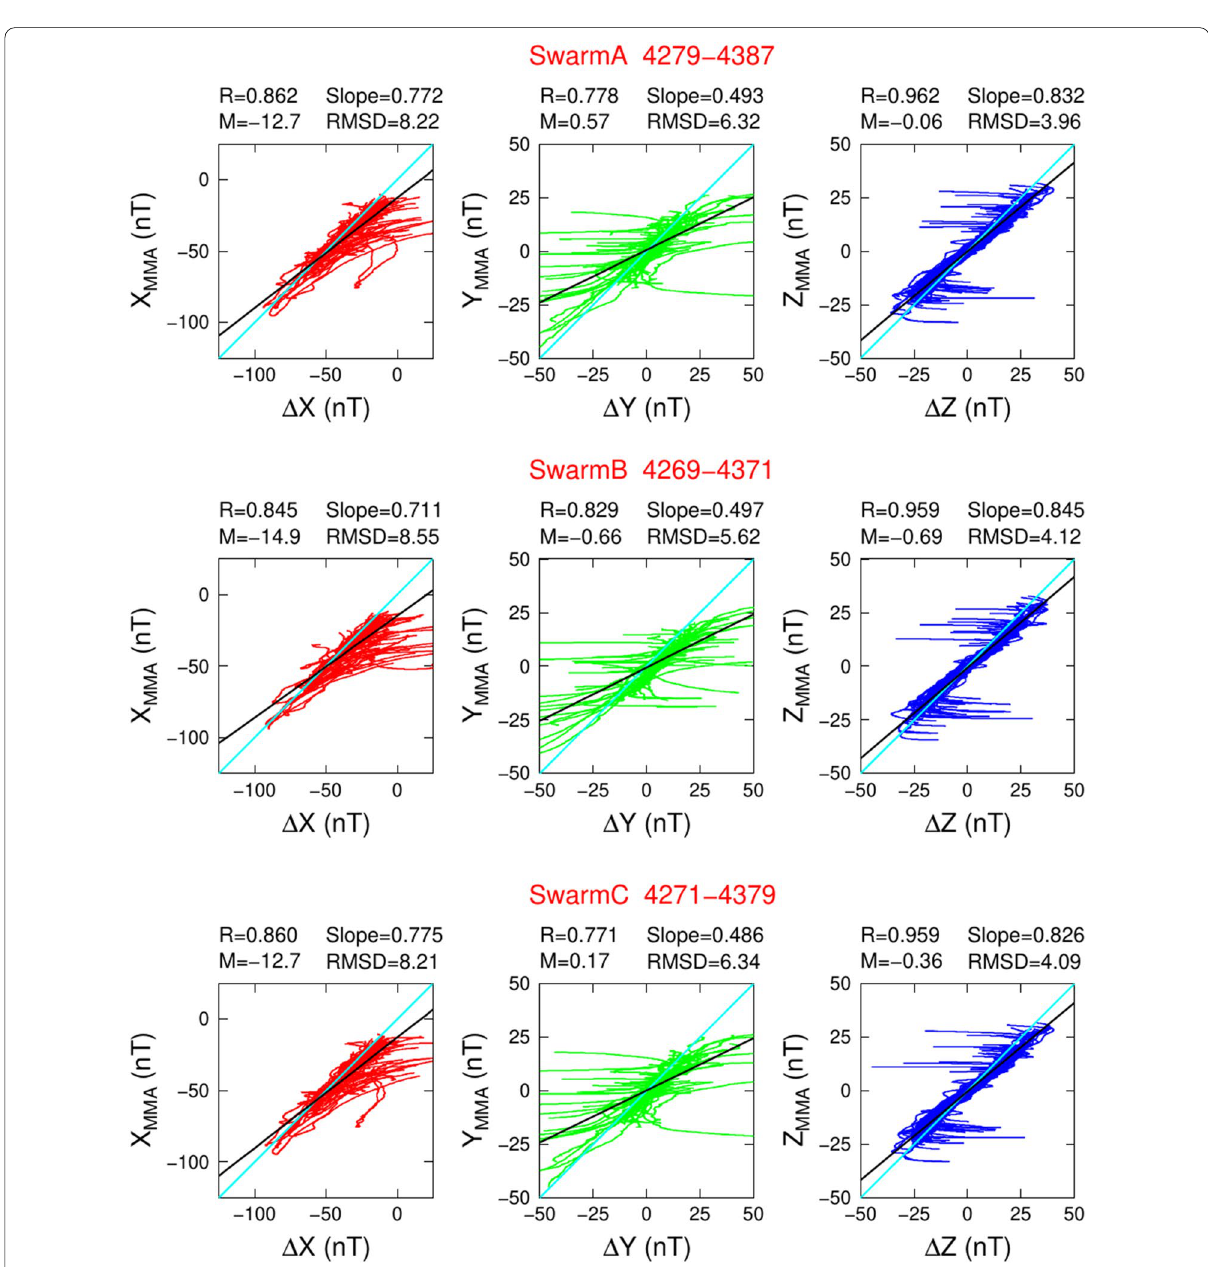
Fig. 1 The scatter plots and linear fits between the Swarm magnetic residuals (cid:31) X (red), (cid:31) Y (green) and (cid:31) Z (blue) and the components X MMA , Y MMA and Z MMA of the MMA model of the magnetospheric magnetic field (Sabaka et al. 2020) along Swarm A (top panels), Swarm B (middle panels) and Swarm C (bottom panels) satellite tracks. The results are shown for a moderate magnetic storm of 84,5-h duration from April 11 to April 15, 2014. The Dst index equals − 81 at the main phase of the storm. Swarm satellite track numbers are given in the headers of panels. Only data from = (ϑ + 10 ◦ , ϑ − 10 ◦ ) , are included. A least-squares regression line is shown by black line. The corresponding the mid-latitude interval I 10 ◦ , I 10 ◦ R n 2 R s 2 ML ML correlation coefficient ( R ), regression slope ( S ) and mean ( M in nT) are shown in each panel. In addition, RMSD (in nT) shows the root mean squares of the differences between the MMA and the predicted values from the regression line. For comparison, light-blue line stands for the exact linear relationship between Swarm residuals and a modelled